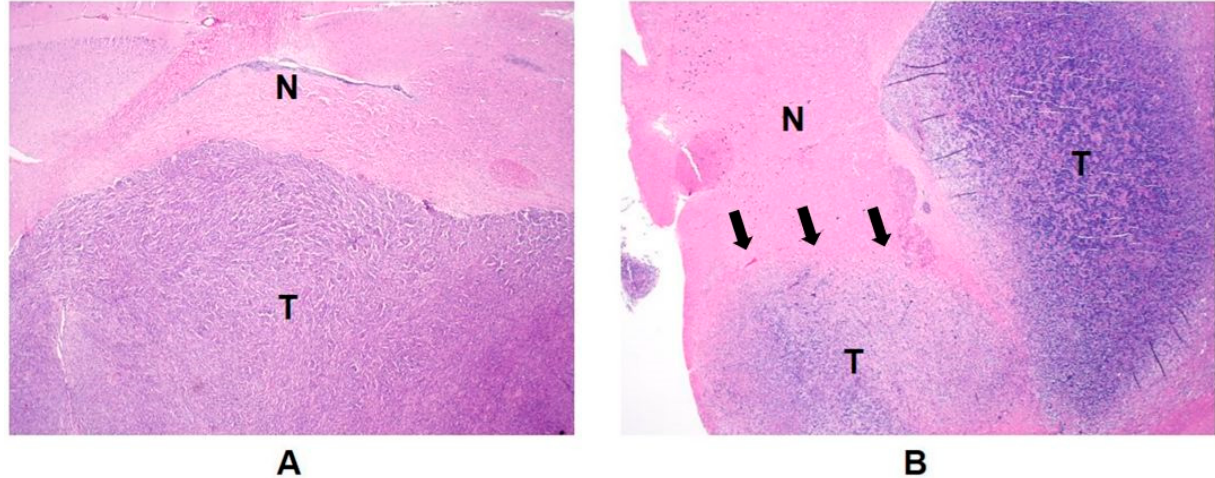
Figure 4. Hematoxylin and eosin (H&E) staining sections revealed a morphological difference in tumor boundaries between the enhancing ( A ) and non-enhancing tumor ( B ). While the glioblastoma model displayed a well-demarcated tumor margin without noticeable tumor cells in the nearby brain tissue ( A ), the diffuse midline glioma model exhibited an unclear tumor margin, with diffusive tumor cells appearing to infiltrate into neighboring brain tissue ( B ). T, tumor; N, normal brain tissue; magnification, ×20.